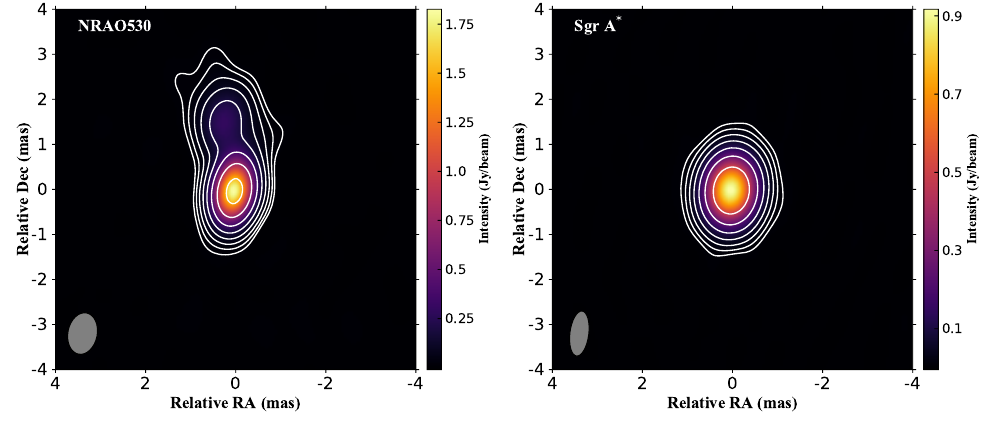
Figure 4. Clean image of NRAO530 ( left ) and model-fitted image of SgrA ∗ ( right ) on 11 May 2019 at 43 GHz. The restoring beam is shown on the lower-left side of each panel. The contour levels start at three times the rms noise value and positive levels increase by a factor of 2. The image parameters are listed in Table